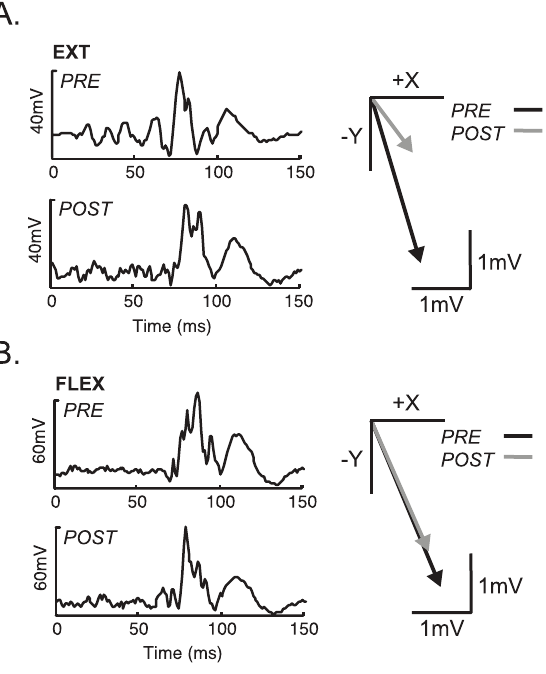
Figure 4. Representative nociceptive withdrawal responses before and after practice from the posterior deltoid (PD) muscle of one subject as well as the average direction and magnitude of the same subjects endpoint force vector for both A) EXT and B) FLEX